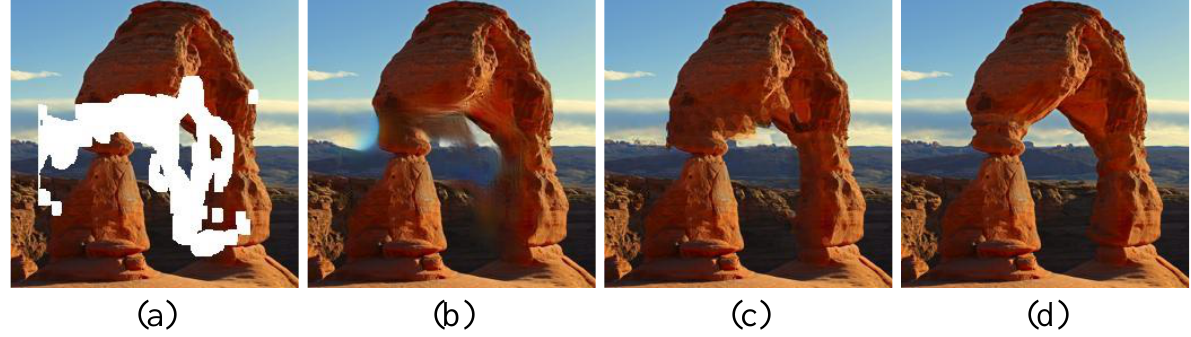
Figure 7. Abalation studies on multi-step structure inpainting model. ( a ) Input image. ( b ) Ours w/o multi-step structure inpainting. ( c ) Ours. ( d ) Ground truth.